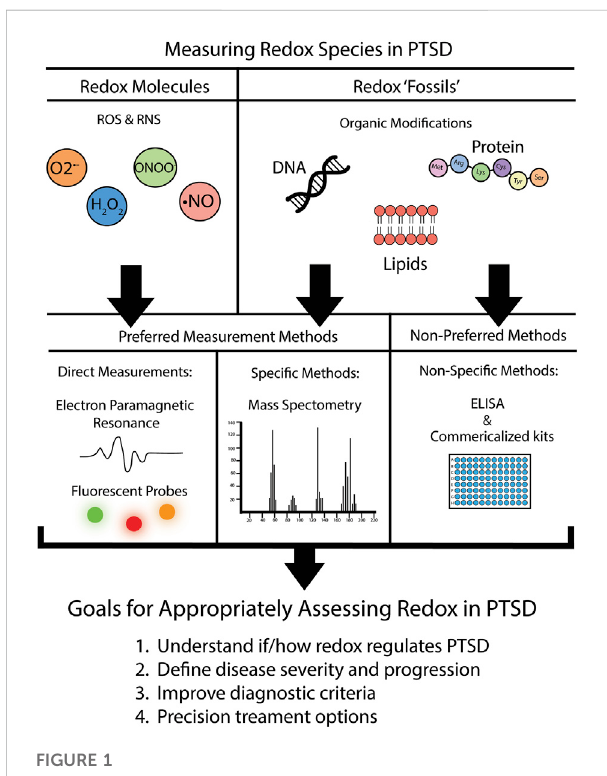
Recommendations for assessment of redox parameters in PTSD. We put forth recommendations of preferred versus